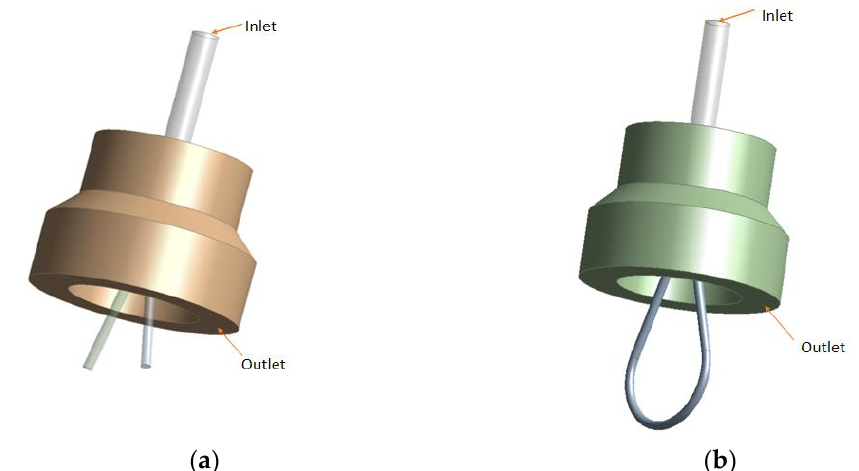
Figure 9. Schematic diagram of setting boundary conditions: ( a ) Block-load model; and ( b ) Con- nected model. Inlet: adopt pressure inlet , pressure p s is 21 MPa, and inlet oil temperature is 300 K. Outlet: pressure outlet is used. The oil return pressure p t is set to 0.5 MPa. Wall surface: slip-free